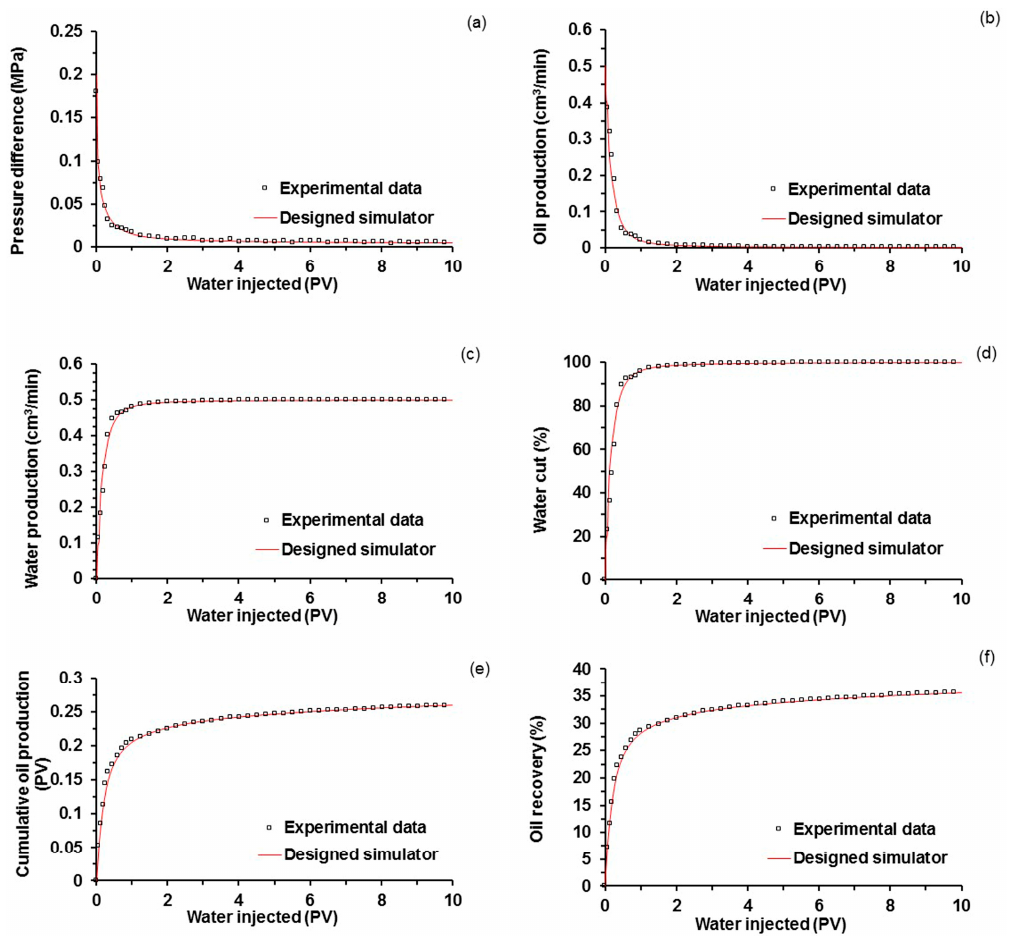
Figure 15. Comparison result of ( a ) pressure difference; ( b ) oil production; ( c ) water production; ( d ) water cut; ( e ) cumulative oil production; and ( f ) oil recovery of the heavy oil displacement experiment and designed simulator in simulating the displacement experiment.